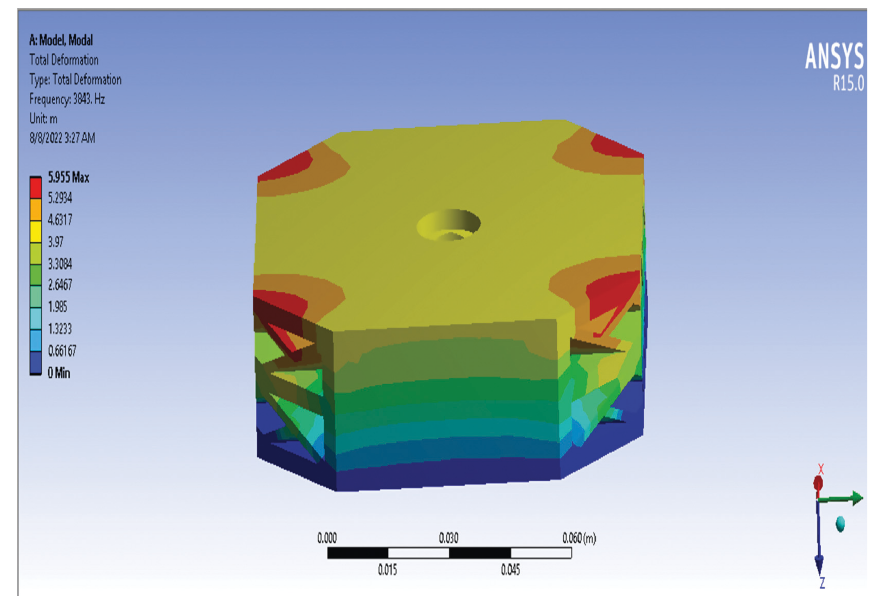
Figure 3: Developed compliant damper and its model analysis report from